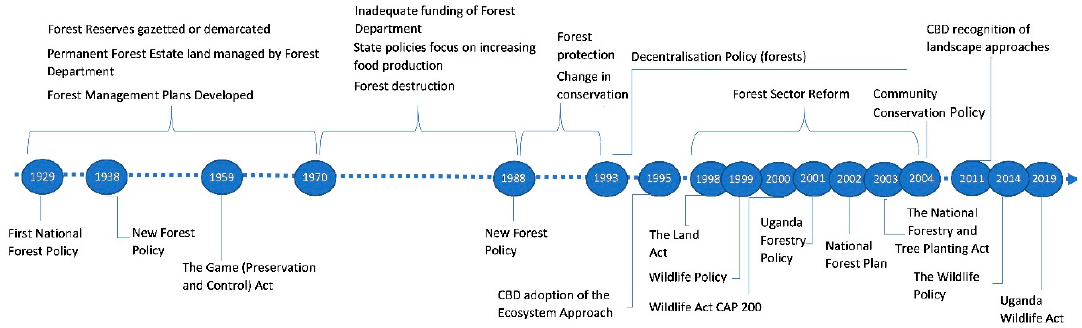
Figure 2. Timeline showing Wildlife and Forest Reserves’ main events and policy.